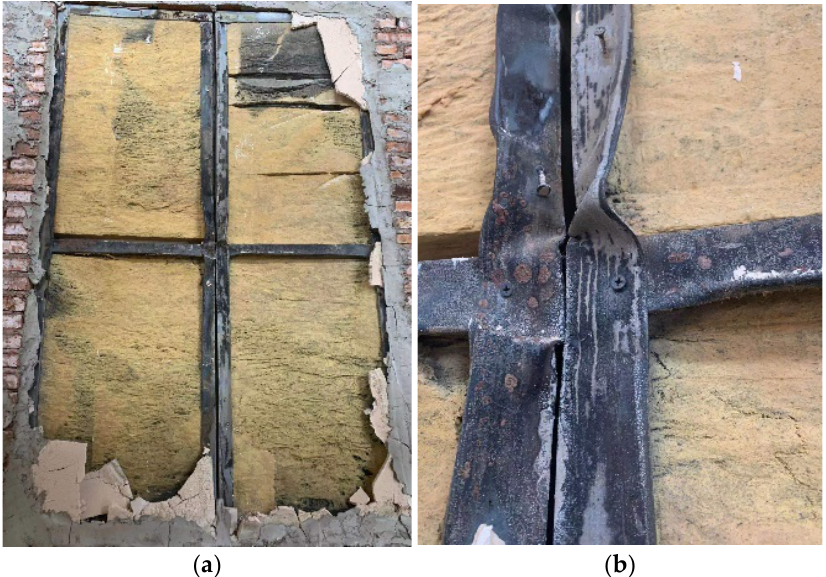
Figure 11. Fire surface ( a ) and sandwich insulation ( b ) of gypsum sandwich wall panels after fire